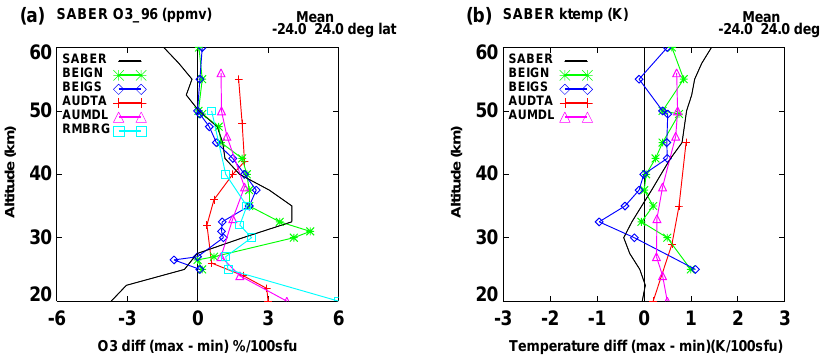
Figure 3. Ozone (left panel) and temperature (right panel) responses to solar activity versus altitude, from 20 to 60km. Values are responses at solar max–responses at solar min in %100sfu − 1 for ozone, and K100sfu − 1 for temperature. Black lines denote SABER responses at the Equator averaged from 24 ◦ S to 24 ◦ N. Red plusses denote Austin et al. (2008) data (AUDTA); magenta triangles denote Austin et al. (2008) models (AUMDL); both are composited from 25 ◦ S to 25 ◦ N. Green asterisks denote responses by Fadnavis and Beig (2006) for 0–30 ◦ N (BEIGN), and blue diamonds Fadnavis and Beig (2006) for 0–30 ◦ S (BEIGS). Light blue squares (RMSBRG) denote results from Remsberg